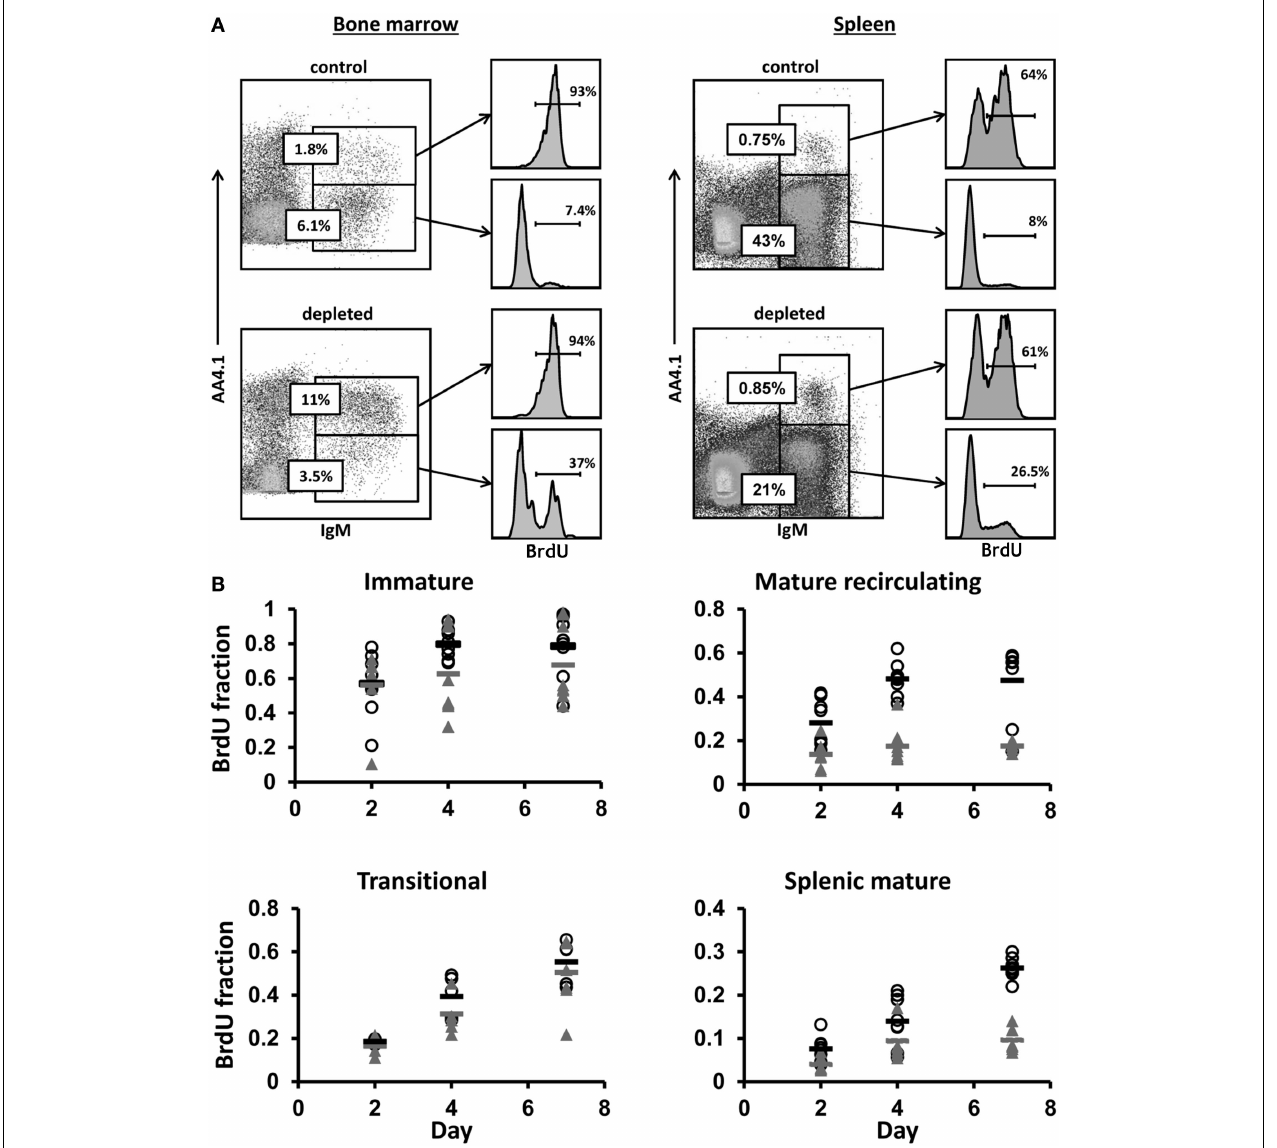
FIGURE 3 | Control and hCD20-depleted mice (34days after depletion) were injected with BrdU and analyzed for BrdU labeling as detailed in Section “Materials and Methods.” (A) BM and spleen cells from the control and the depleted mice were stained for IgM, AA4.1 and BrdU labeling. For analysis, viable lymphocytes were defined by forward and side light scatter, and the relative BrdU labeling in BM immature (IgM + /AA4.1 + ) and mature-circulated (IgM + /AA4.1 (cid:0) ), and in spleen transitional (IgM + /AA4.1 + ) and mature (IgM + /AA4.1 (cid:0) ) B cells was determined using gates set as shown (representative example). (B) BrdU labeling kinetics in B cell-depleted (black, open circles for each single mouse and band for the mean value) and control (gray, filled triangles for each single mouse and band for the mean value) mice. For total cell numbers, see Figure 4 .